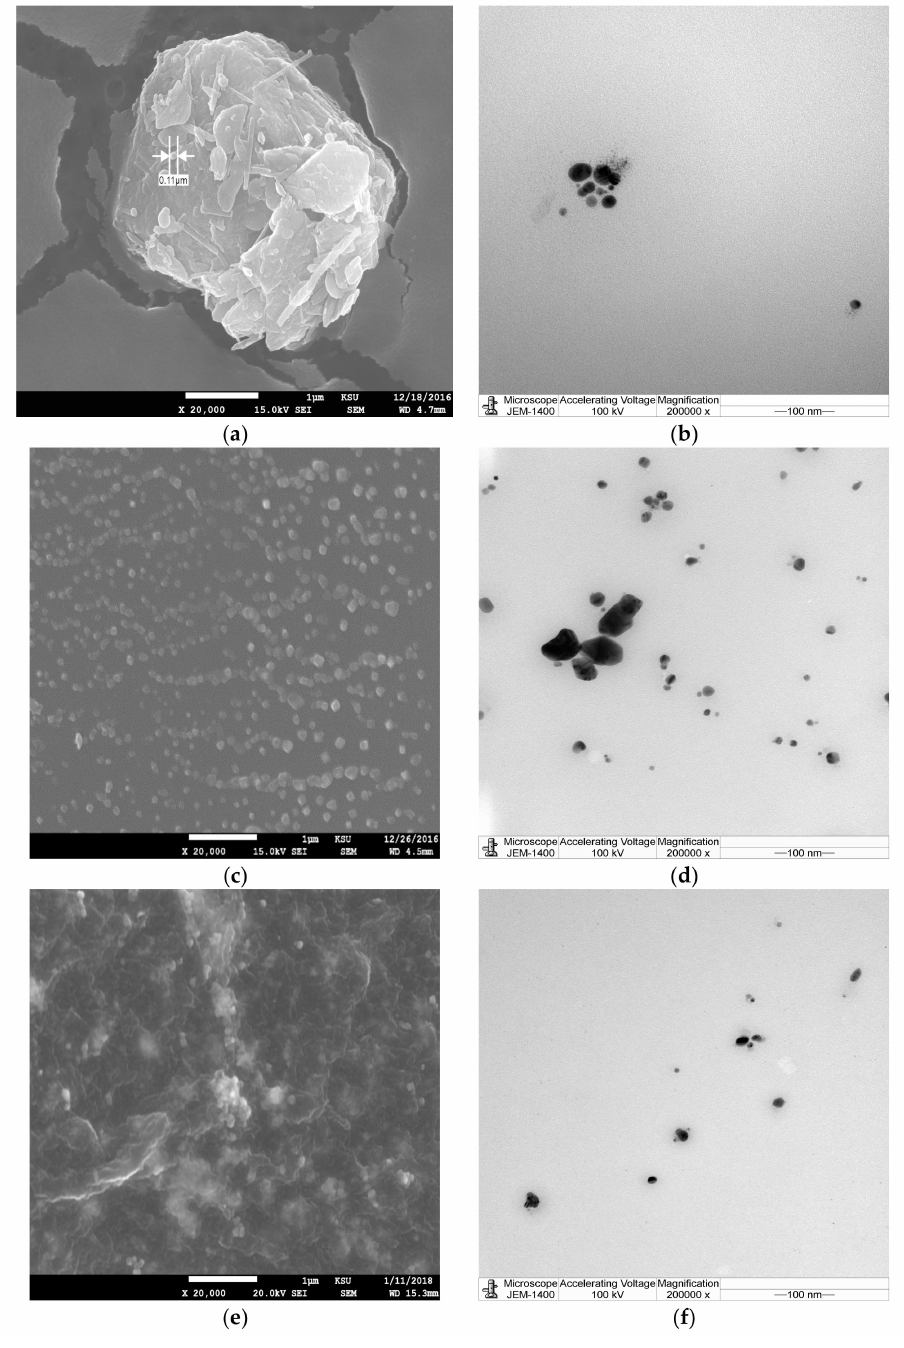
Figure 1. Scanning electron microscope (SEM) images ( a – c ) and the corresponding transmission electron microscopy (TEM) images ( d – f ) of silver nanoparticles obtained using alcoholic extracts of Phoenix dactylifer , Acacia nilotica , and Ferula asafetida . Magnification is 20,000 × and the scale bar represents 100 nm for TEM images and 1 µ m for SEM